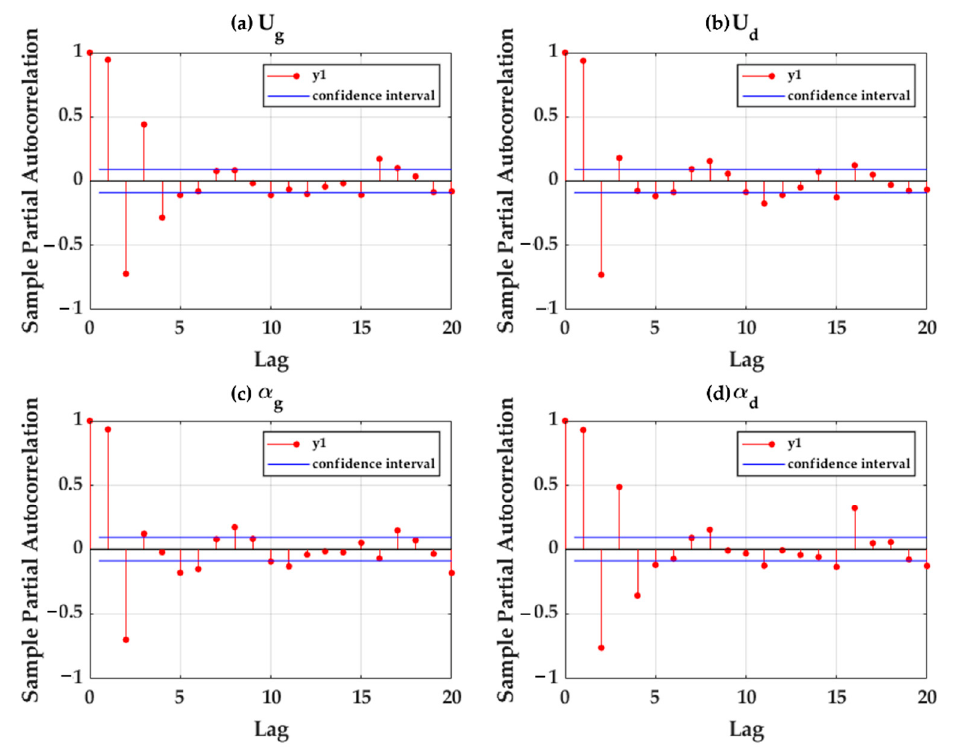
Figure 12. Partial autocorrelation function curves (PACF) of first order differenced time-series of